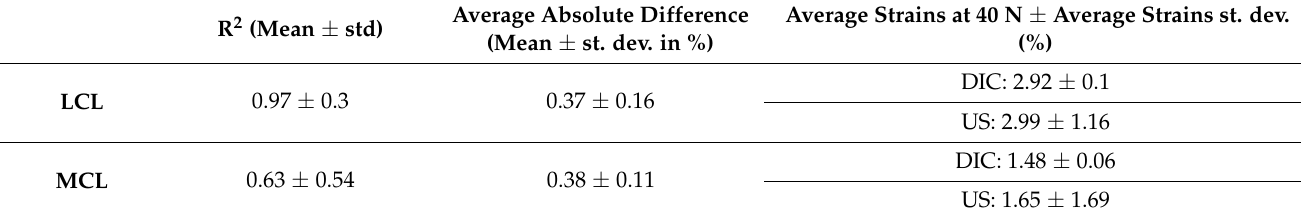
Table 3. Average results over all valid specimens from the “optimization” group obtained during the optimization process with the optimal parameter set of each ligament. Results of the linear correlation coefficient (R 2 ) between the digital image correlation (DIC) and ultrasound (US) strains, and mean absolute difference over the entire loading range (in %) are expressed as average values over all specimens from the “optimization” group ± standard deviation. DIC and US strains at 40 N are reported as the average values over all specimens from the “optimization” group ± average within-specimen standard deviation in %.